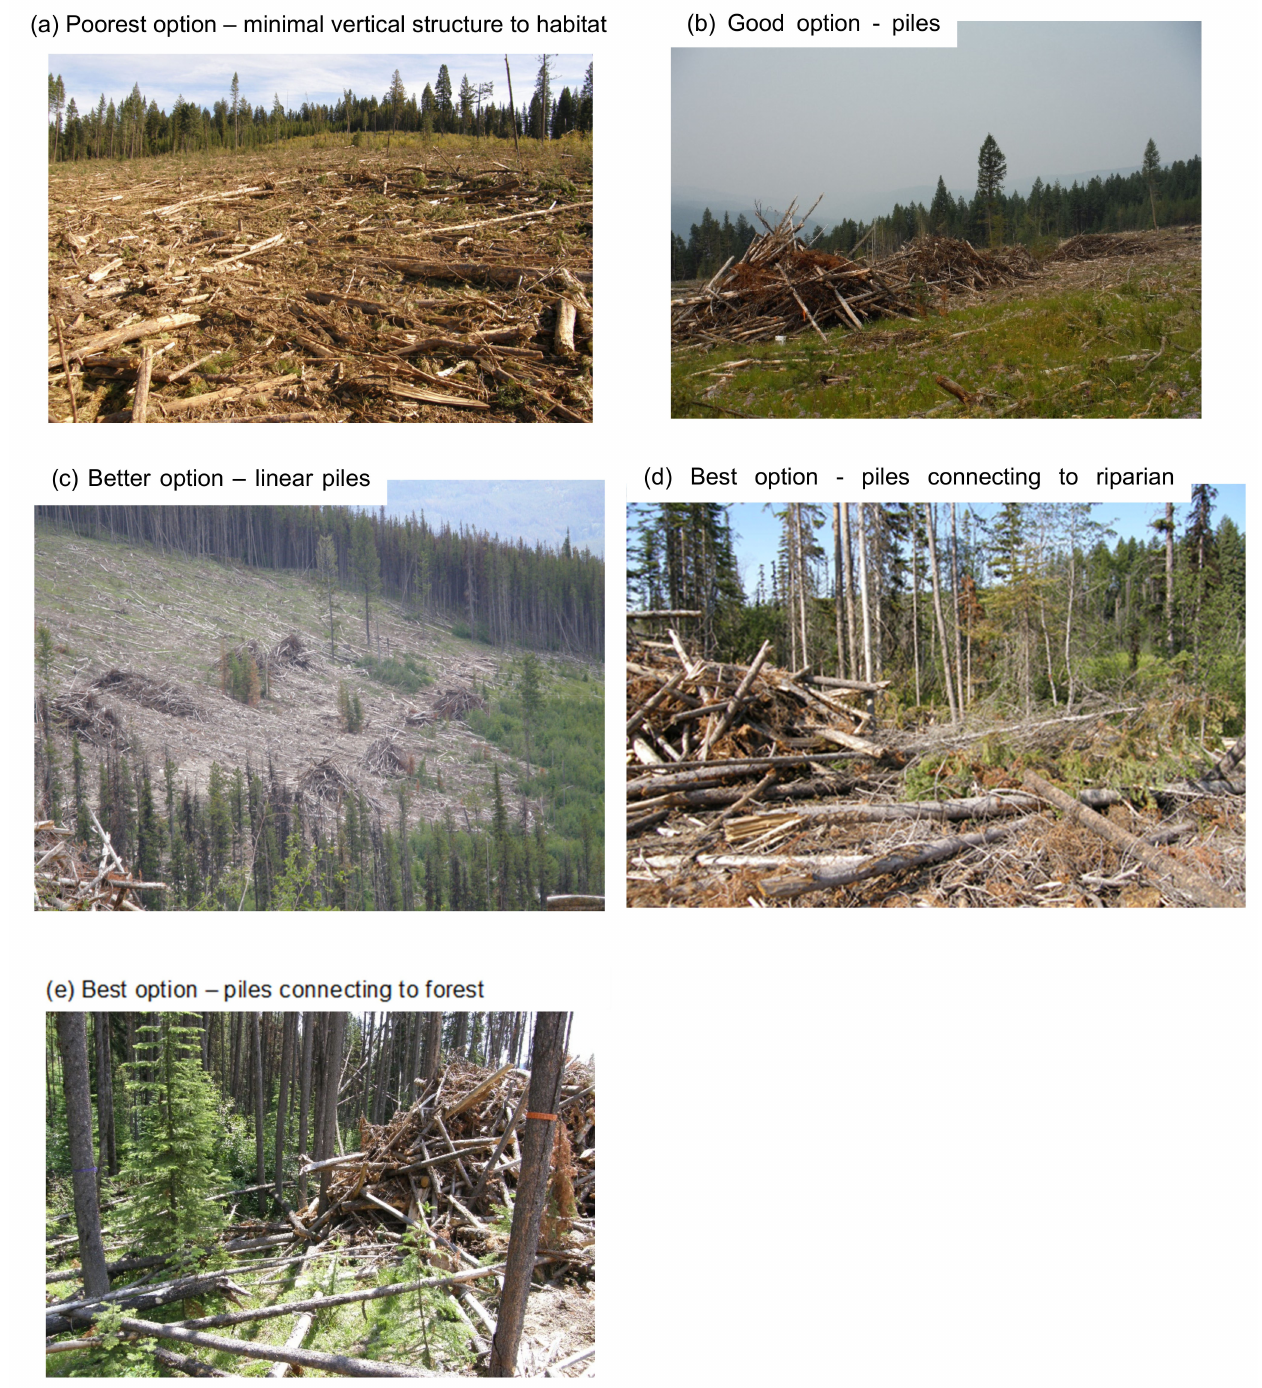
Figure 3. Options for construction of woody debris habitats: the poorest ( a ) minimal vertical structure to habitat; good ( b ) piles; better ( c ) linear row of piles; and best ( d ) piles connecting to riparian; and best ( e ) piles connecting to forest